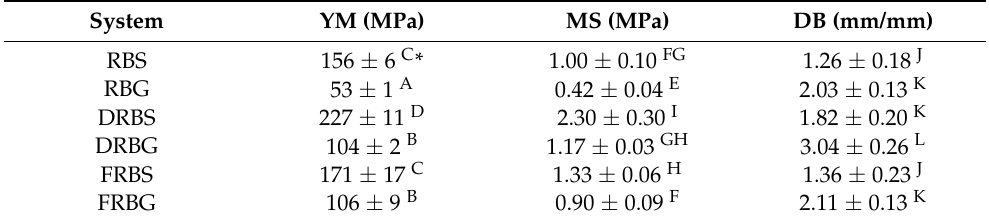
Table 2. Young’s modulus (YM), maximum stress (MS) and deformation at break (DB) of the different evaluated systems obtained from the stress-strain curves.